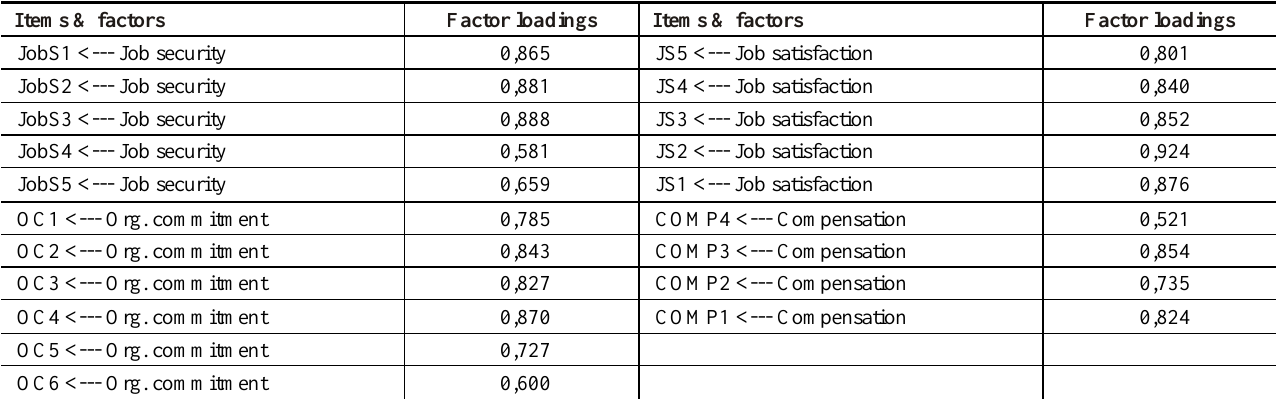
Table 2: Factor loadings